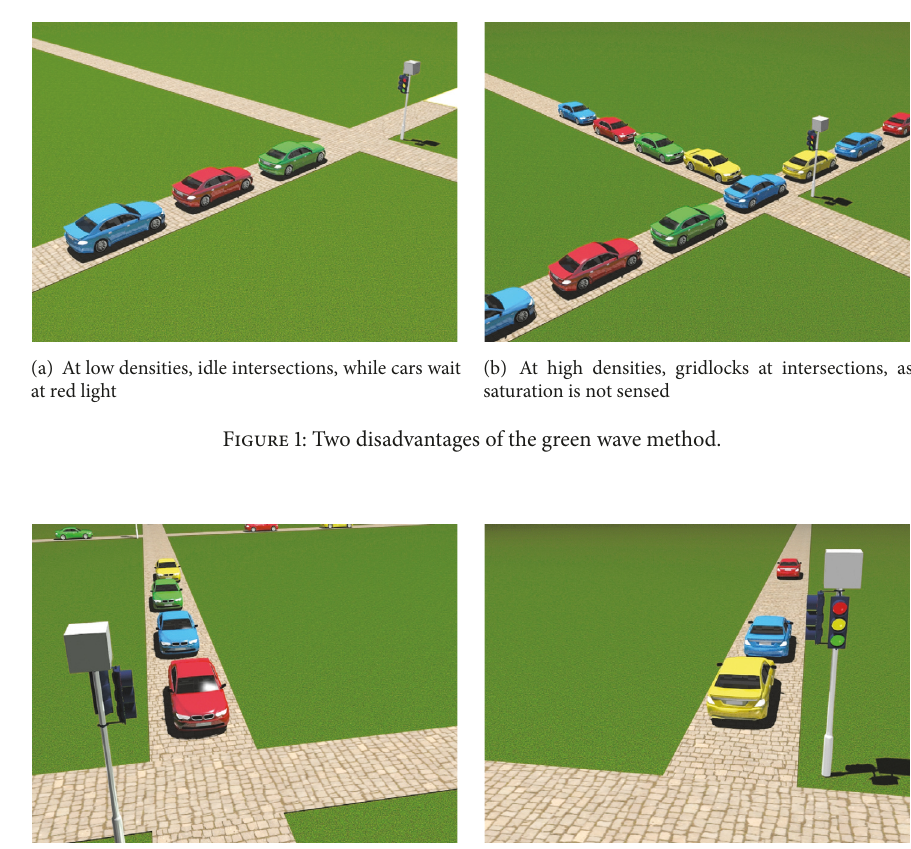
densities, gridlocks at intersections are formed because the controller does not consider road saturation (see Figure